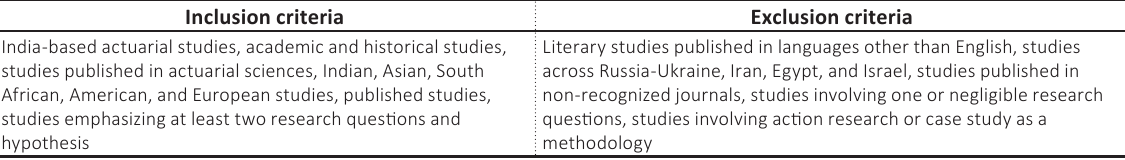
Table 2. Inclusion and exclusion criteria set Inclusion